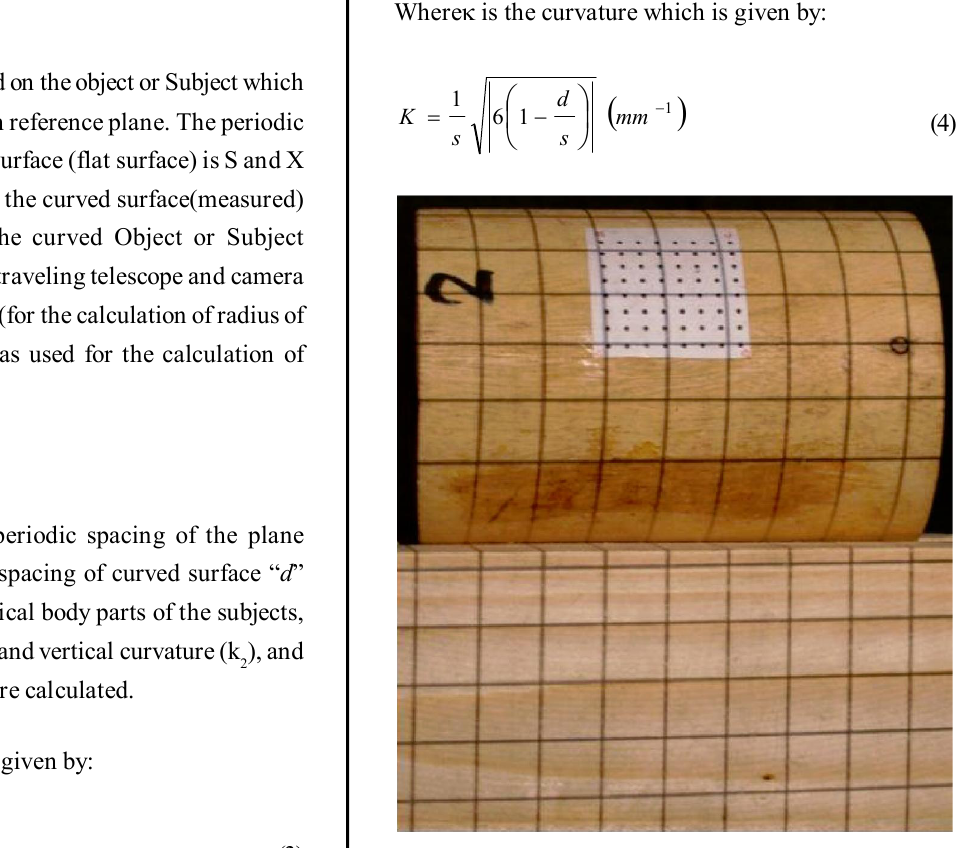
FIG. 2. CYLINDER AND PLANE